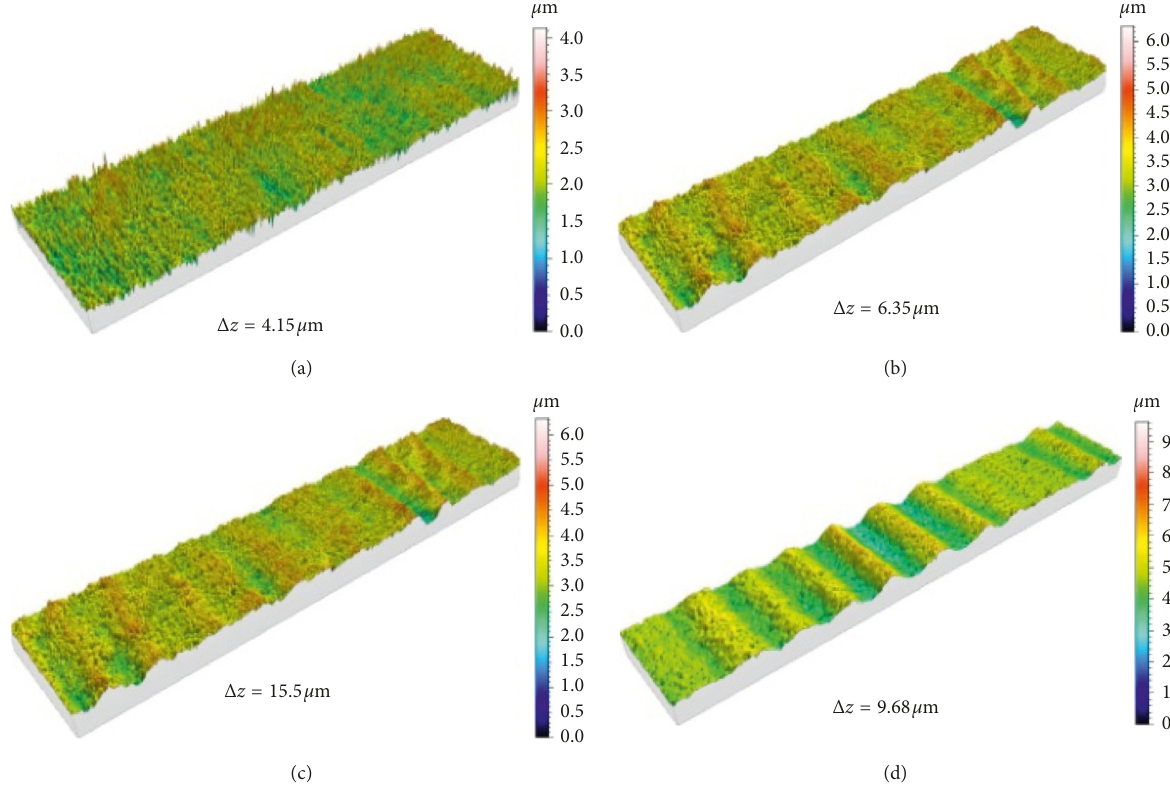
2 ) in a bath without ER: (a) sample without cm · 2 ); and (d) after electropolishing in 0.20A cm − (cid:31) · −